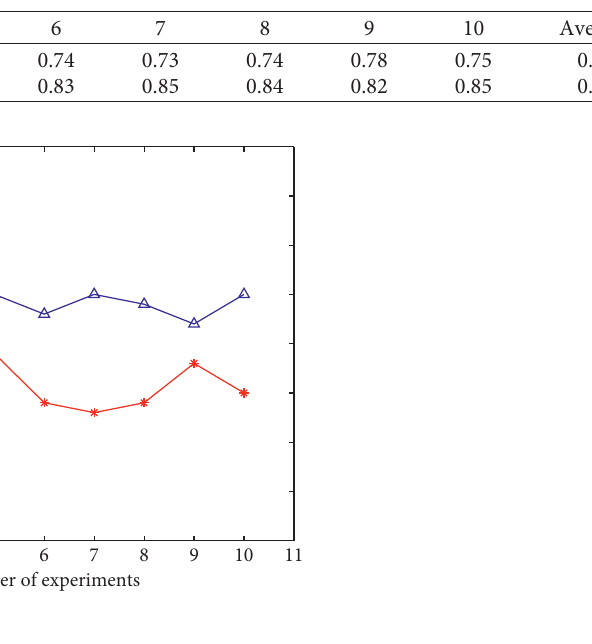
Table 3: Classification accuracy of BP algorithm and WNB algorithm.